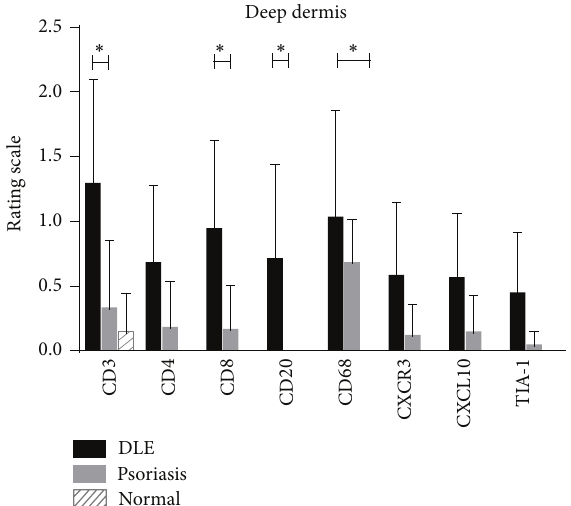
Figure 4: Comparisons of staining of T cell, B cell, and macrophage markers (CD3, CD4, CD8, CD20, CD68, CXCR3, CXCL10, and TIA-1) in the deep dermis of DLE lesional skin ( 𝑁 = 23 ), psoriasis lesional skin ( 𝑁 = 11 ), and normal skin ( 𝑁 = 5 ). DLE lesional skin expressed higher amounts of CD3 + T cells, CD8 + T cells, CD20 + B cells, and CD68 + cells than at least one of the control populations studied. ∗ 𝑃 < 0.01 ; ∗∗ 𝑃 < 0.001 ; ∗∗∗ 𝑃 < 0.0001